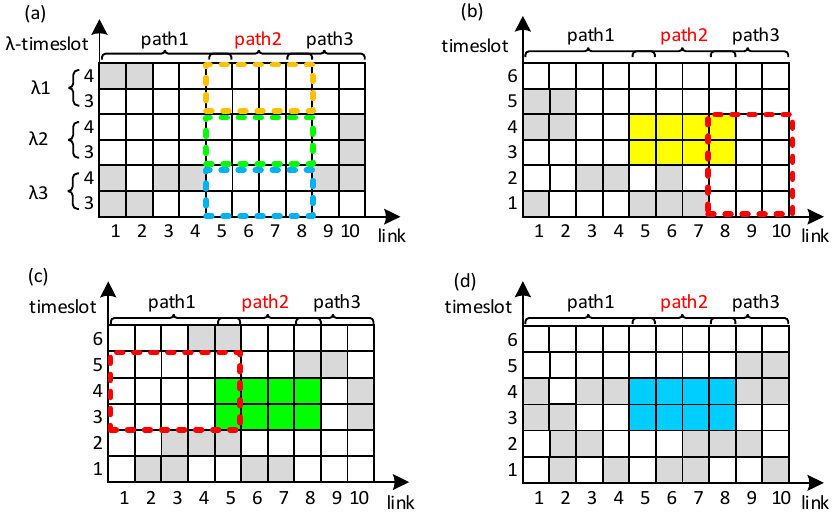
Figure 3. An example of wavelength-timeslot fragments in RWTA: ( a ) Three possible solutions on wavelengths λ 1, λ 2, and λ 3; ( b ) Resource status on λ 1 after solution A; ( c ) Resource status on λ 2 after solution B; ( d ) Resource status on λ 3 after solution C.